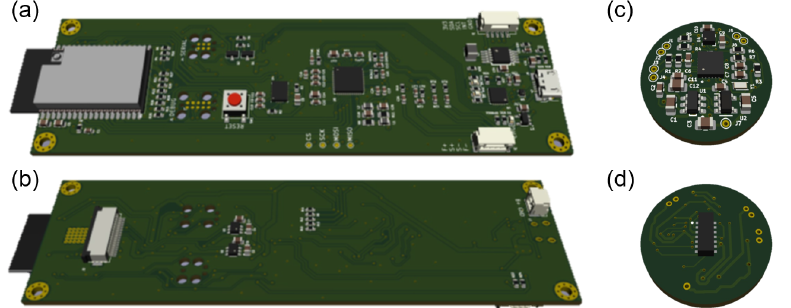
Figure 2. PCBs of the platform. ( a ) Top view of the main PCB, attached to the front of the device by means of a lightweight plastic bracket. It contains the power and communications control system (RS232 and Bluetooth, plus a USB port), the main microcontroller, the chip for EDA, the gyroscope and accelerometers (IMU) and the LIPO battery (including its charger) that powers all the electronics. ( b ) Bottom view of the same PCB, where the camera connection port and its power sources are located (left and center, respectively). The size of this PCB is 38 mm × 124 mm. ( c ) Top view of the